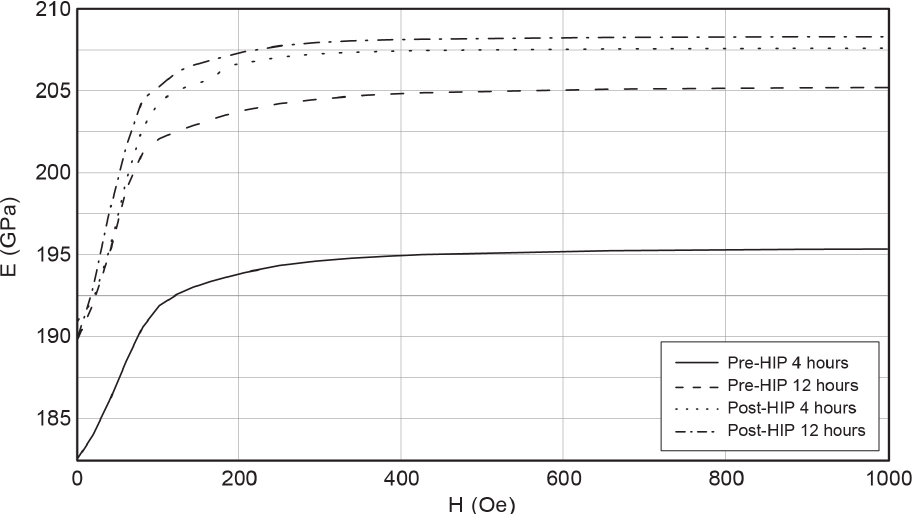
Figure 5. ∆ E of the samples sintered in N 2 -5%H 2 at 1325 °C during 4 and 12 of plateau without and with HIP treatment. Table 2. ∆ E in the samples subjected to the different heat treatments. Sintering Magnetic